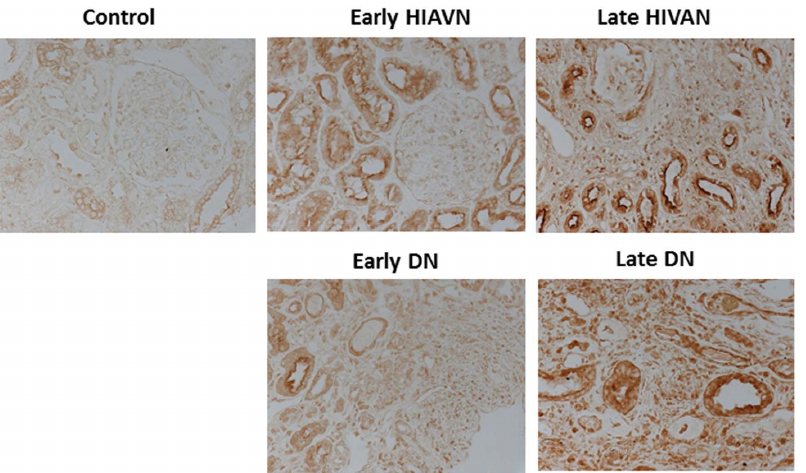
Figure 14. Immunostaining of Spon1 in kidney biopsies from patients with nephrectomy (control), early and late HIVAN and DN. The representative pictures from five individual patients are shown.